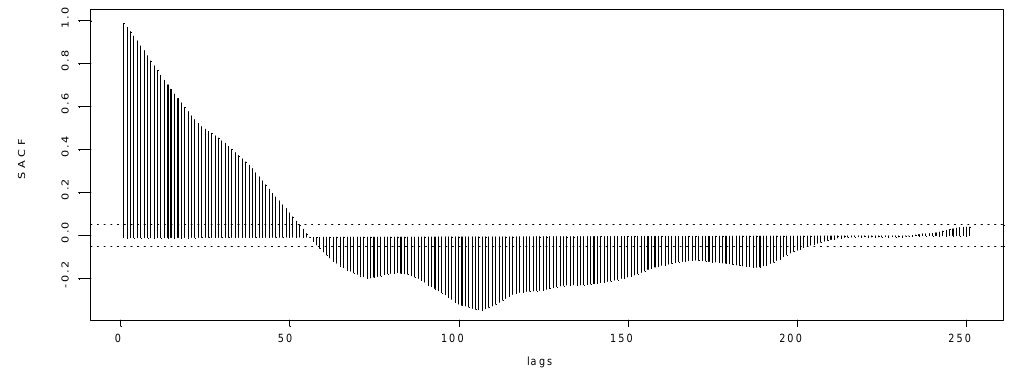
Figure 2: Sample autocorrelation of cointegration residual series between China and US AC F of cointegration residual between China and U S m arkets